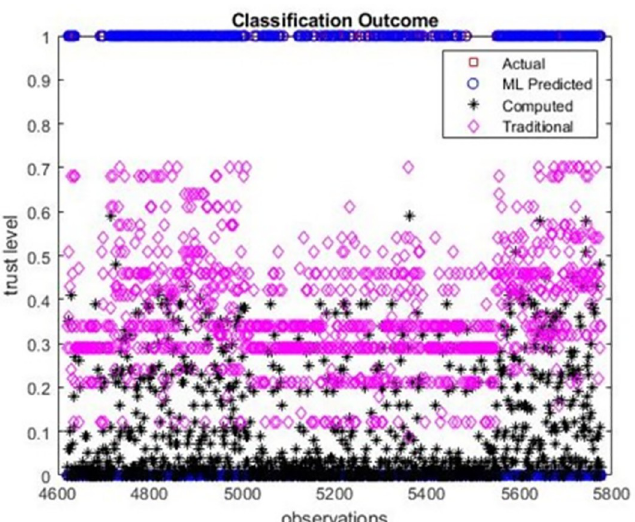
Fig 10. Classification results for testing data compared to computed and traditional approaches (q = 0.5).